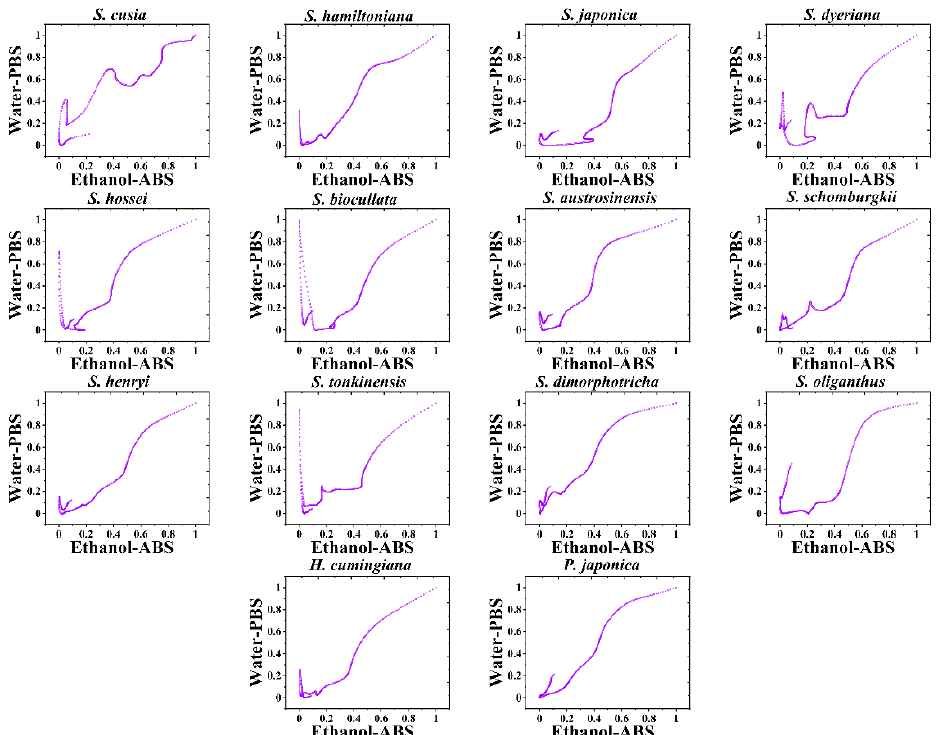
Figure 3. Scatter patterns of S. hossei, S. japonica, S. dimorphotricha, S. cusia, S. biocullata, S. oliganthus, S. hamiltoniana, S. austrosinensis, S. henryi, S. tonkinensis, S. schomburgkii, S. dyeriana, S. hamiltoniana,